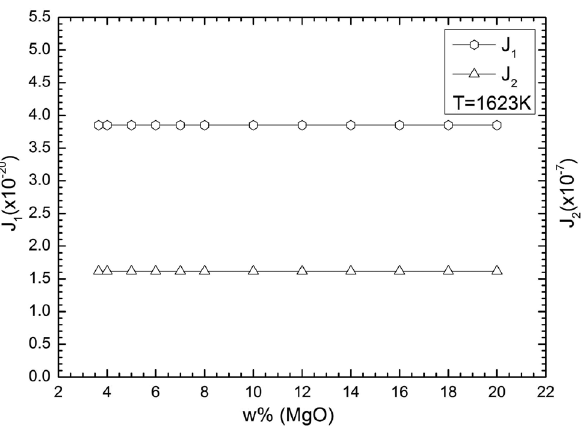
Fig. 5: The variation of activity product of J 1 and J 2 with MgO content